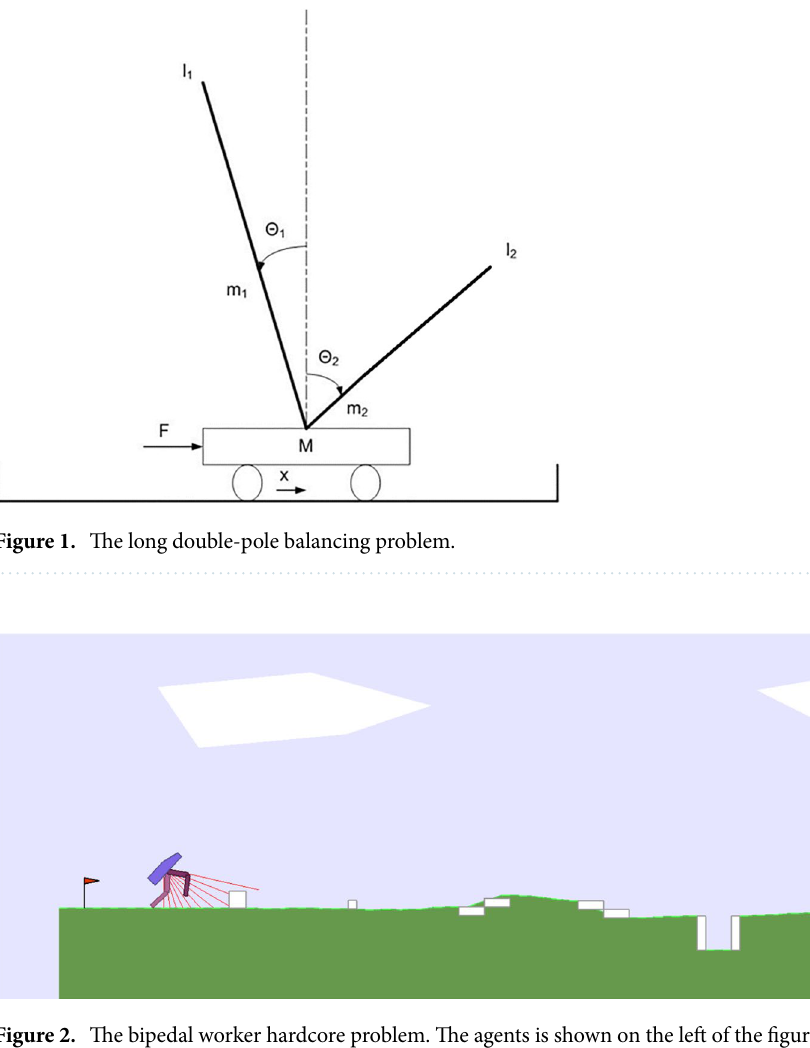
Figure 2. The bipedal worker hardcore problem. The agents is shown on the left of the figure. In this example the environment includes, from left to right, a large stump, a small stump, an uphill stair, a downhill stair, and a hole. The type of each of the five obstacles vary in evaluation